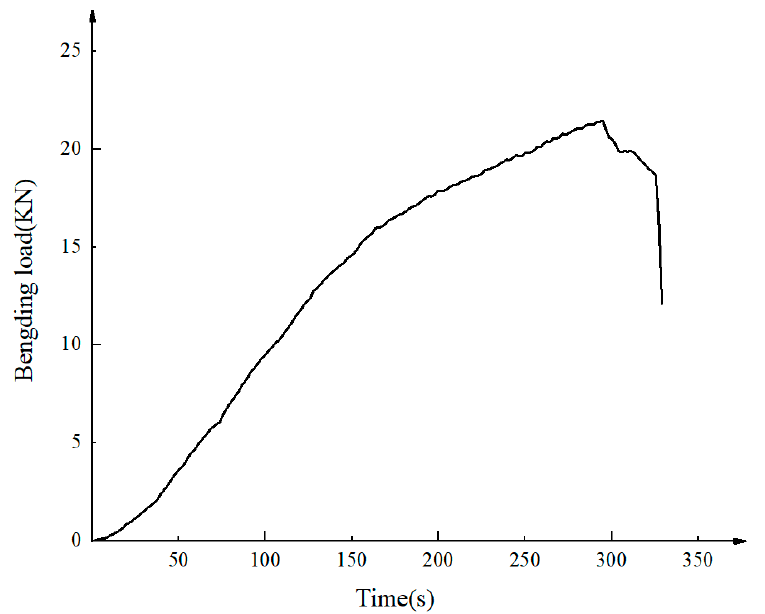
Figure 6. Pressure curve at 500 mm below the furnace roof.